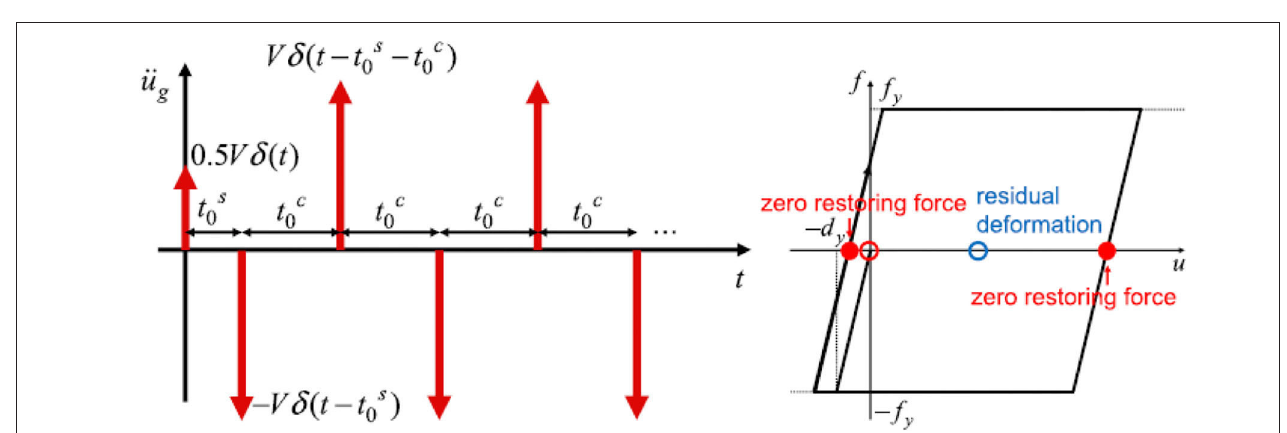
FIGURE 2 | Critical multi impulse, Input Sequence 2, for SDOF model (Kojima and Takewaki, 2015b).